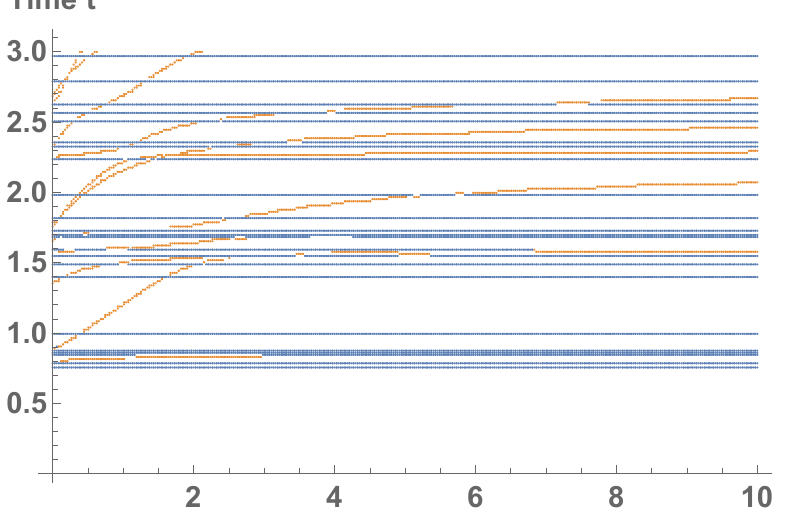
Figure 10 . The times of all conjugate points with the integrable 4-body deformation δH 1 with N = 6 fermions. This plot and figures 11 and 12 are made by identifying all of the zeros of Y µ at each fixed µ point and sampling a lattice of time values, rather than by tracking the motion of individual conjugate points. Consequently, it may be difficult to distinguish conjugate points that lie within a lattice spacing of each other for certain values of µ . Some of the more easily distinguishable nonlocal conjugate points are highlighted in orange by hand, while the blue lines correspond to µ -independent local conjugate